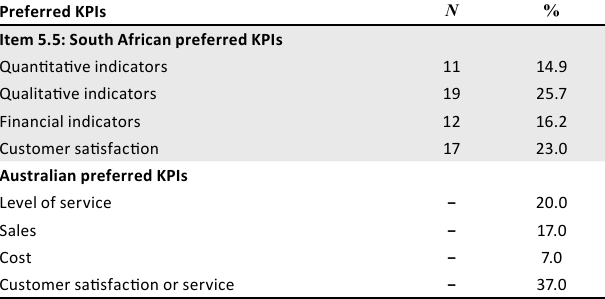
TABLE 11: Preferred KPIs for call centre managers in South Africa and Australia. Preferred KPIs